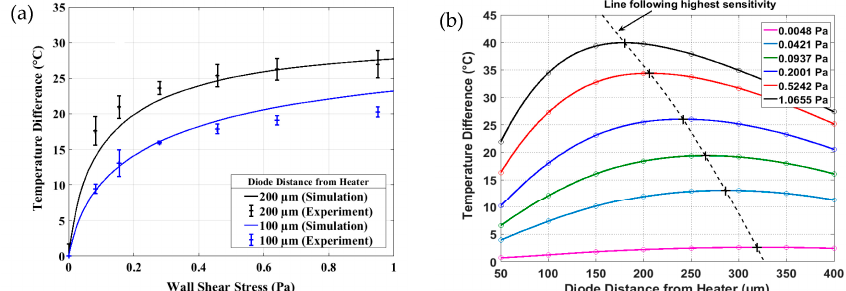
Figure 2. ( a ) Temperature difference against wall shear stress for the calorimetric method and ( b ) temperature output as a function of diode distance from central heater for varying wall shear